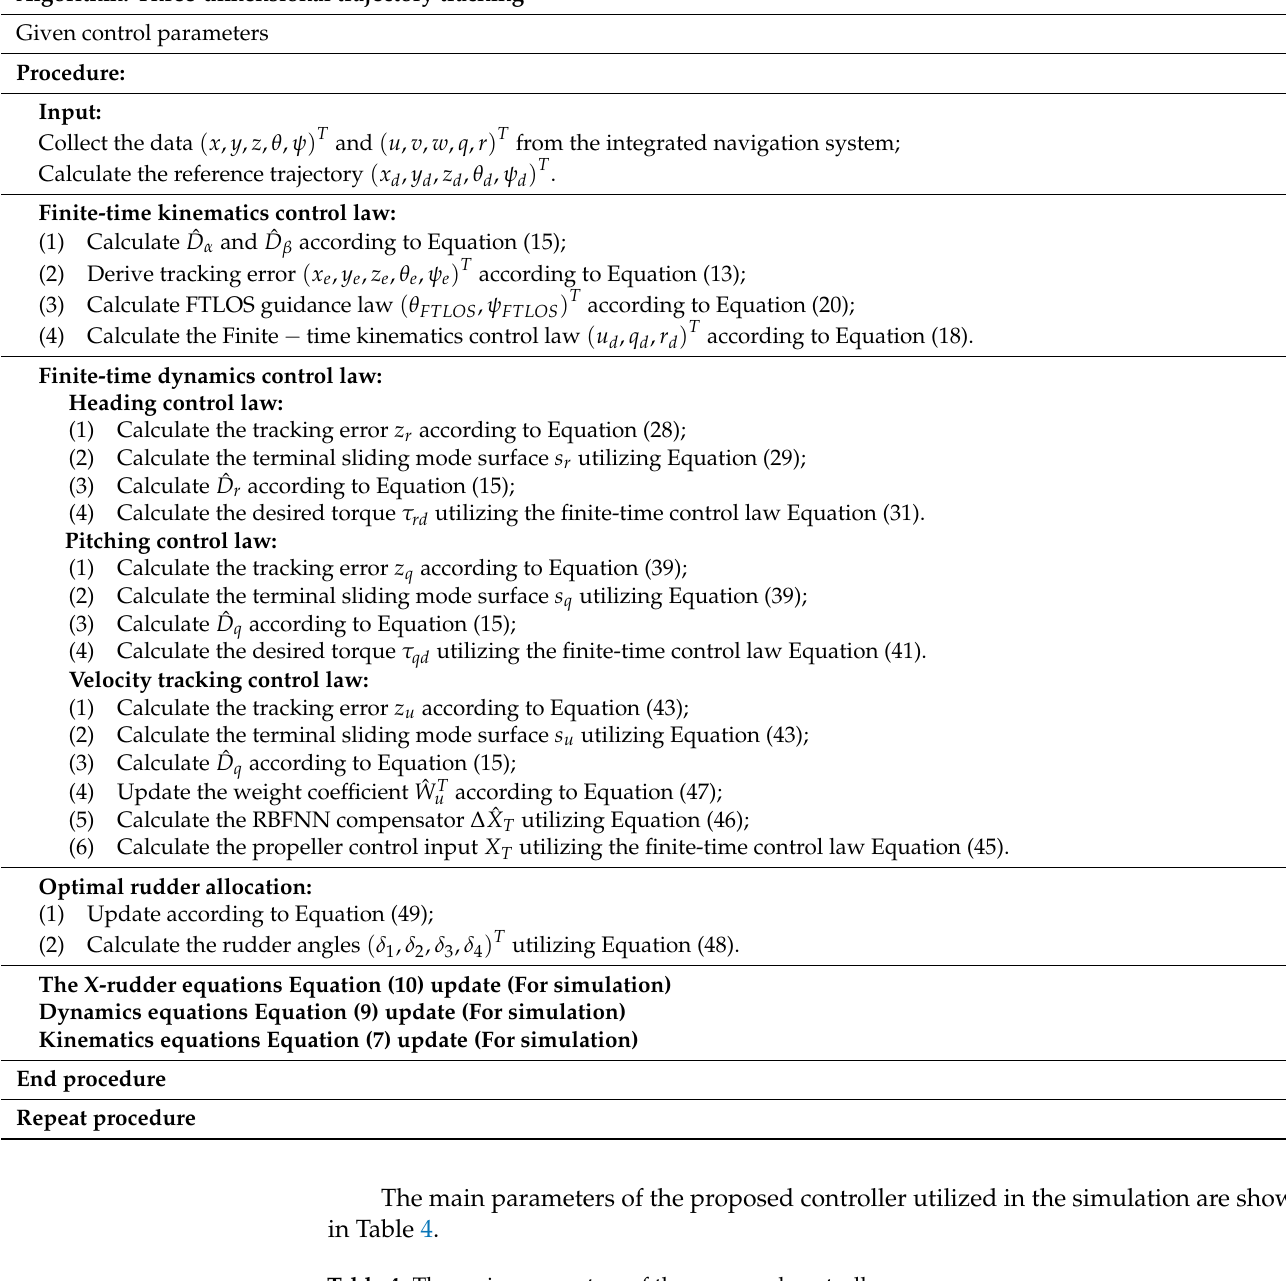
Table 4. The main parameters of the proposed